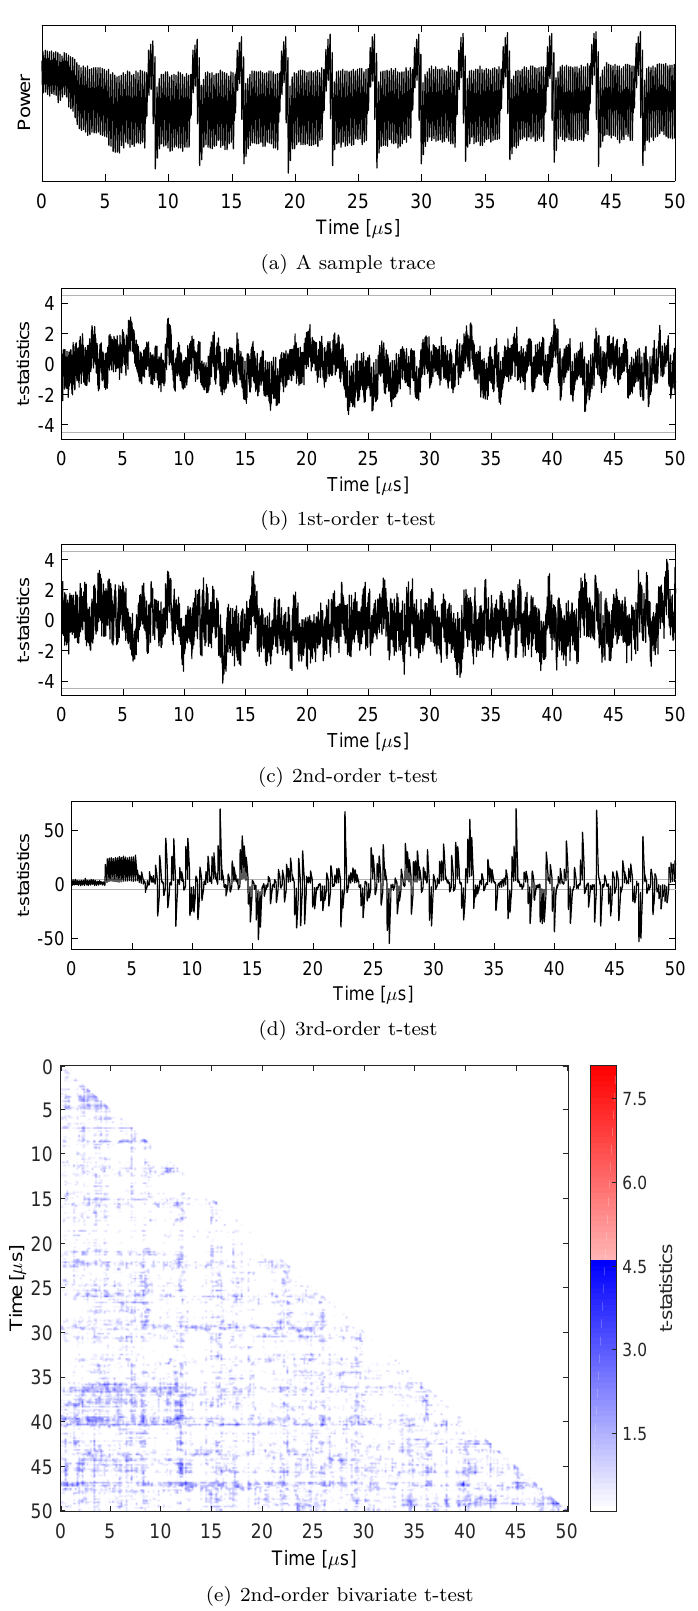
Figure 10: Experimental analysis of our second-order secure round-based PRESENT encryption design, 100 million